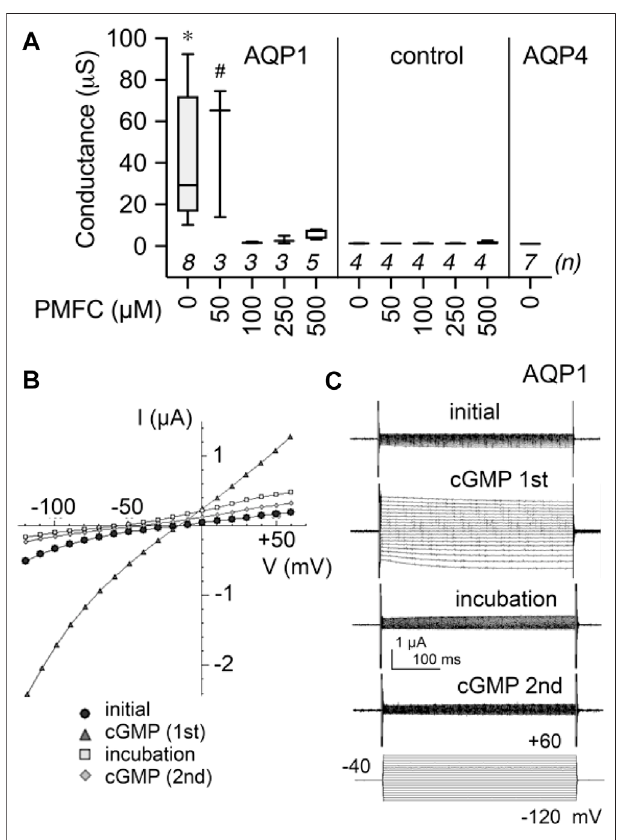
FIGURE 4 | Dose-dependent inhibition of AQP1 ion channel conductance by 5-PMFC. (A) Box plot compilation of SNP-activated conductance values measured after 1 – 2 h incubation with the indicated concentration of 5-PMFC in isotonic saline. Conductances were calculated from slopes of current-voltage (I – V) plots measured at 8 min after applicationof3 mMextracellularSNPusedtostimulateintracellularcGMP.No current activation by SNP was observed in non-AQP controls with or without 5-PMFC incubation, or in AQP4-expressing oocytes. n values in italics are abovethe x -axis.Signi fi cantdifferenceswerefoundbetweenAQP1at0 µM5- PMFC(*)andallothertreatmentgroupsshown,exceptAQP1at50 µMPMFC (#) which was not signi fi cantly different from AQP1 0 µM 5-PMFC. Statistical signi fi cance was assessed by one-way ANOVA and Š idák ’ s multiple comparisons test; * p < 0.01; # not signi fi cant. (B) Current-voltage plots of responsesrecordedinseriesfor thesame AQP1-expressingoocyte,showing initial low conductance, activation by SNP ( ‘ cGMP 1st ′ ), recovery during 2 h incubation in 500 µM 5-PMFC (incub PMFC), and block of the second response to SNP ( ‘ cGMP 2nd ′ ). Reversal potentials shifted from near − 20 mV intheinitialandcGMP(1st)conditionstoapproximately − 50 mVafter5-PMFC treatment(inincubationandcGMP(2nd)conditions),consistentwithinhibition ofanon-selectivecationconductance,andnotnativeoocyteK + channels. (C) Traces illustrating data shown in the I-V plots in